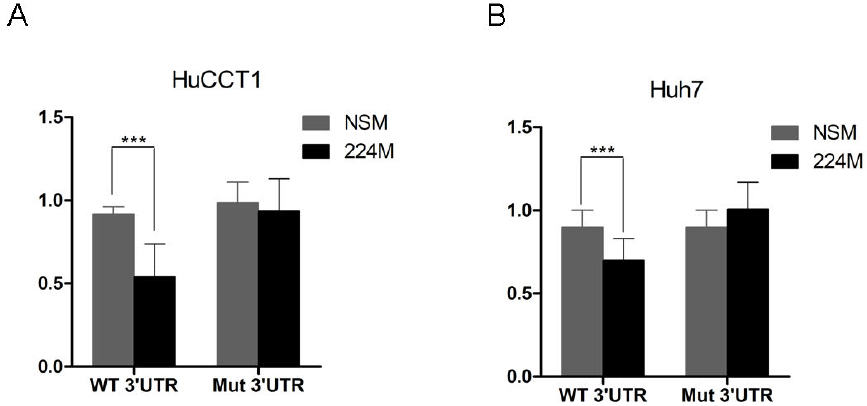
Figure 6. miR-224 directly interacts with the binding site in the 3 ′ UTR of p21 mRNA. Luciferase assay was performed in both HuCCT1 ( a ) and Huh7 ( b ) cells. Y-axis: relative luminescence normalized to the luminescence level in NSM (non-specific mimic) treatment; x-axis: treatment conditions. NSM: non-specific mimic, 224M: miR-224 mimic; WT 3 ′ UTR: correct orientation fragment of p21 3 ′ UTR containing miR-224 binding site; Mut 3 ′ UTR: fragment of p21 3 ′ UTR containing a mutated miR-224 binding site. Shown